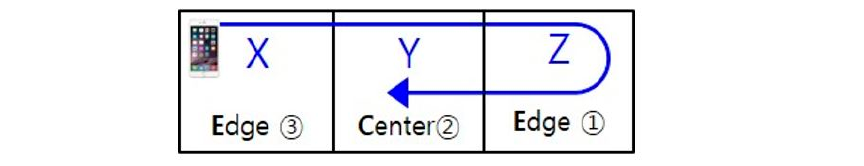
Figure 3. Edge and center zones in a 3Z system.